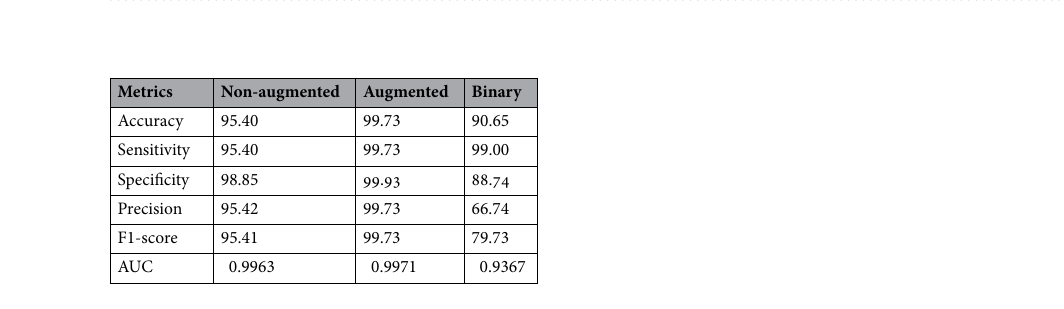
Table 11. Comparison of the average performance metrics of different datasets.